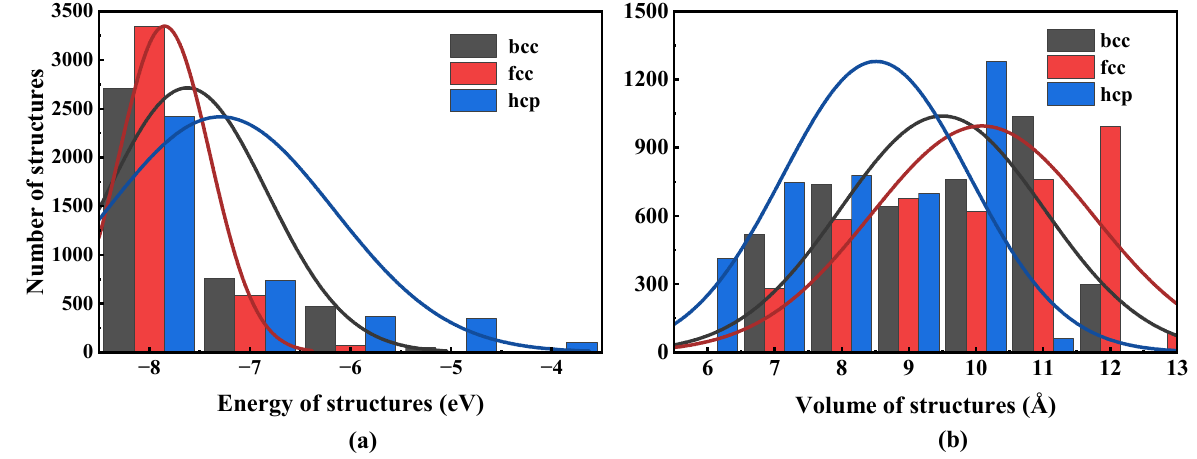
Figure 6. Distribution for bcc, hcp, and fcc Fe. ( a ) Energy distribution histogram; ( b ) volume distribution histogram.